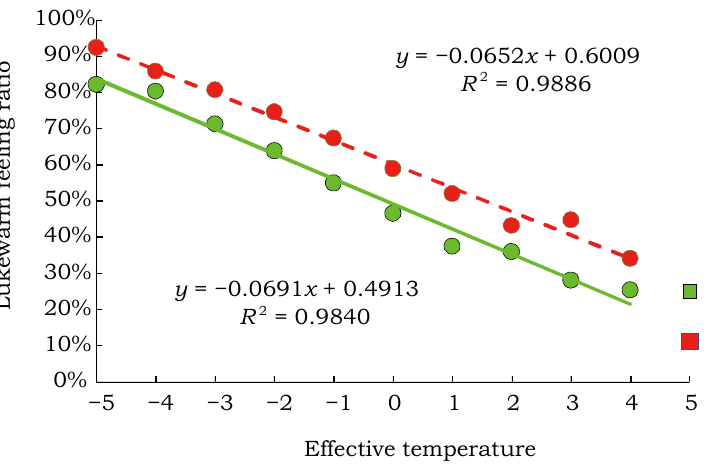
Figure 1. Effective temperature and lukewarm feeling ratio Note: The red dashed line shows the JPC Survey data carried out between 1990 and 2000, where N = 10,536; the green line shows the Survey X data (2004–2013) where N =